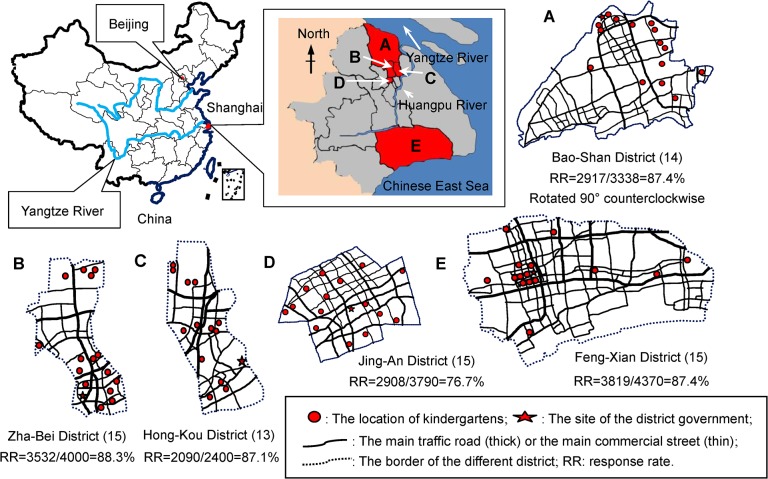
Distribution of kindergartens in this survey.The number in the bracket is the number of kindergartens we have surveyed in the district. Because most of the kindergartens in Feng-Xian District (E) are located in the center of district, the kindergartens we surveyed in this district are relatively centralized.